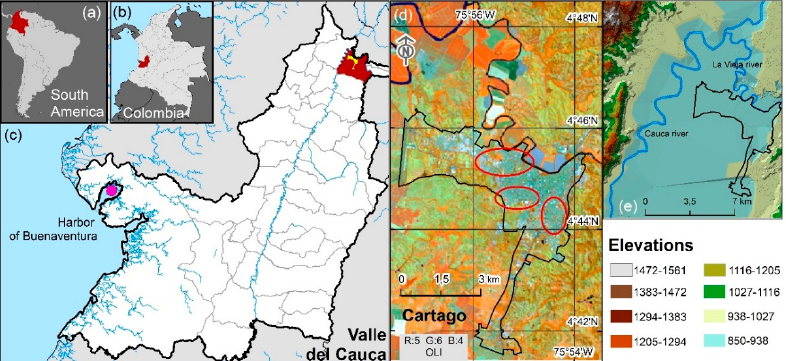
Figure 1. Location of the study area. ( a ) South America: Colombia highlighted. ( b ) Location of Valle del Cauca in Colombia. ( c ) Cartago in Department of Valle del Cauca. ( d ) Cartago, Landsat 8 OLI band combination (R:5, G:6, B:4). ( e ) Digital Elevation Model.